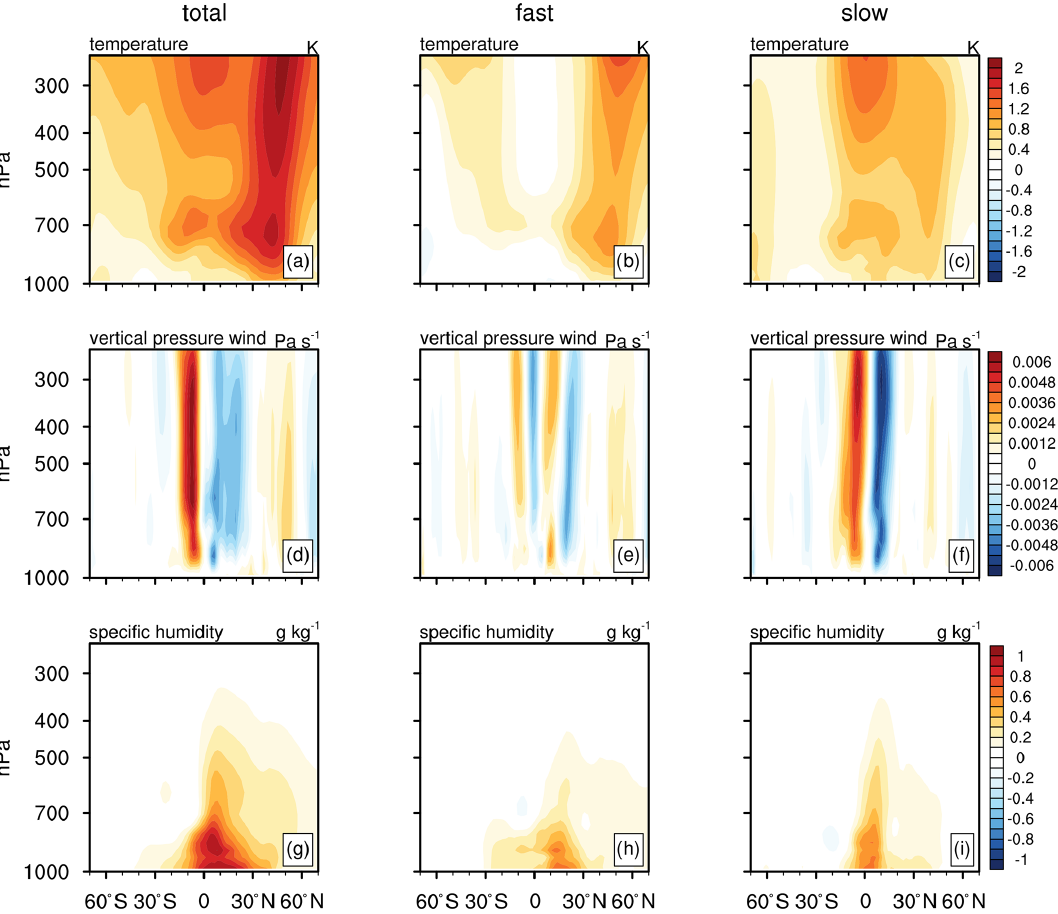
Figure 6. ECHAM6–HAM2 simulated multi-annual (a, d, g) total, (b, e, h) fast, and (c, f, i) slow responses of zonally averaged (a–c) temperature, (d–f) vertical pressure velocity, and (g–i) specific humidity in response to 10-fold increased BC emission. Blue colours indicate large-scale ascent, and red colours indicate large-scale descent in (d–f)